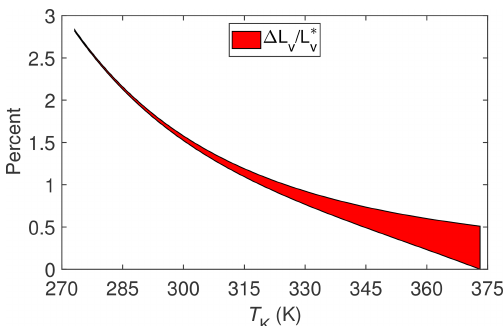
Figure 2. % change in L ∗ v from Eq. (7), where (cid:49)L v on the y axis label is used in place of I B /χ v . The upper curve bounding the red shaded area is (cid:49)L v /L ∗ v for a process occurring at constant volume and the lower boundary is for an isobaric